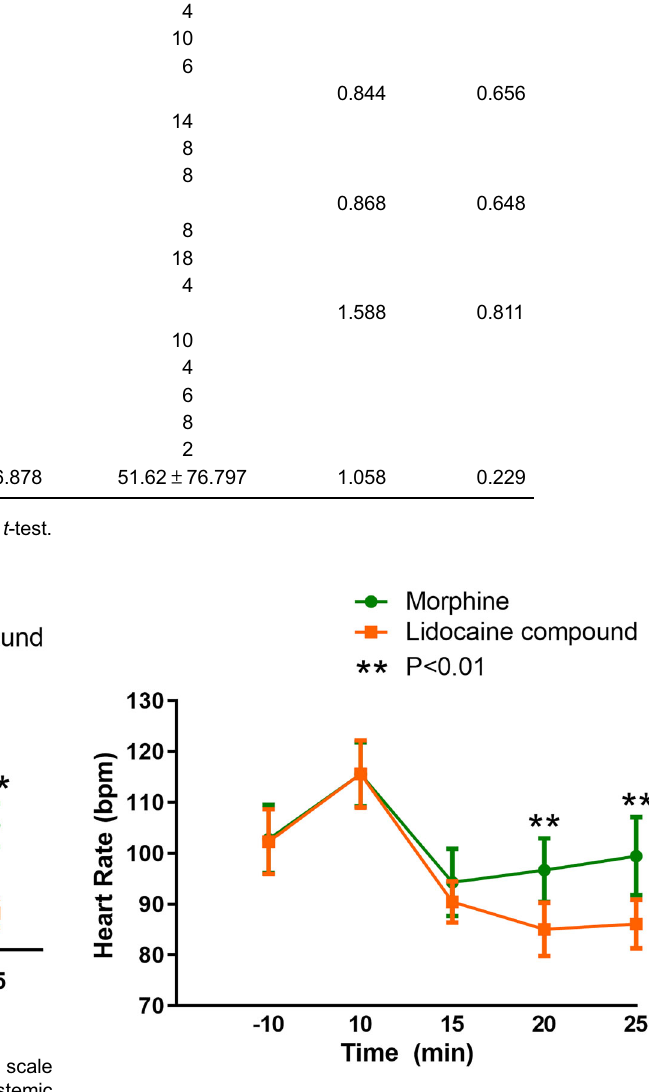
Figure 2. Comparison of heart rates in different time periods between the two groups receiving systemic morphine or topical lidocaine for cancer wound dressing change. Data was collected 10 min before the treatment and 10, 15, 20 and 25 min after. Data are reported as means ± SD. Student ’ s t -test was used for statistical analysis (P o 0.01).